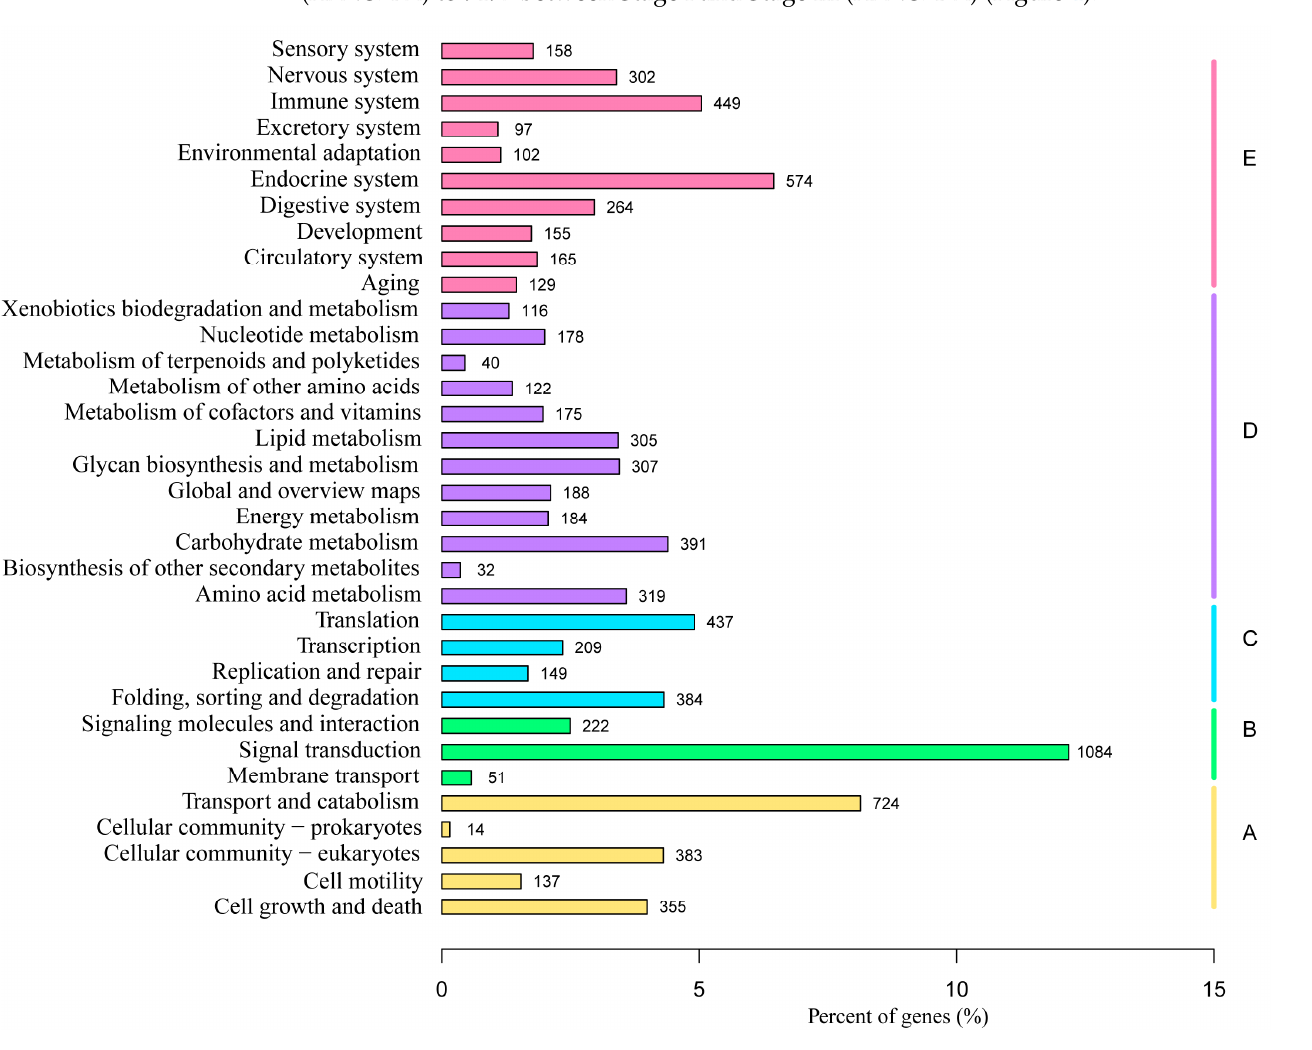
Figure 3. Unigene KEGG enrichment classification of the gonad transcriptome of Macrobrachium rosenbergii .